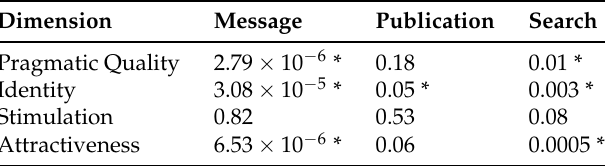
Table 5. p values for paired-samples t -tests (comparisons between AUX and EUX in each dimension). Dimension